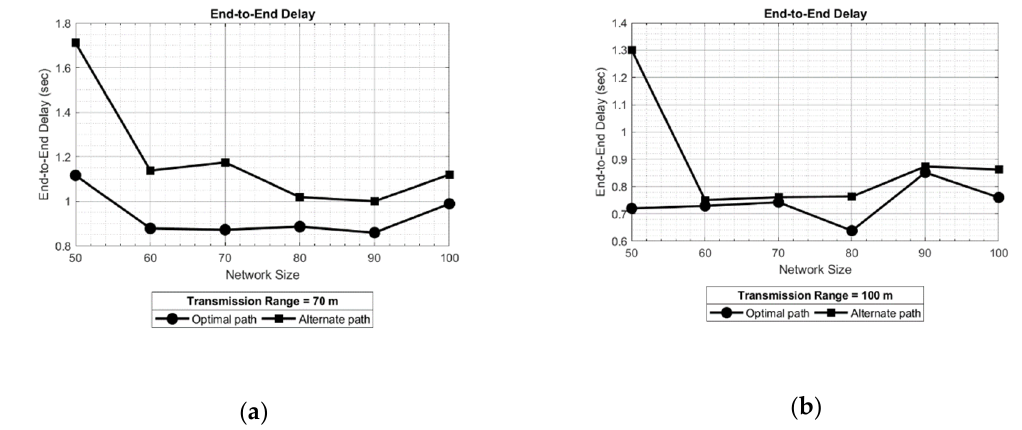
Figure 16. End-to-end delay for optimal and alternate paths for different transmission ranges: ( a ) 70 m, ( b ) 100 m.